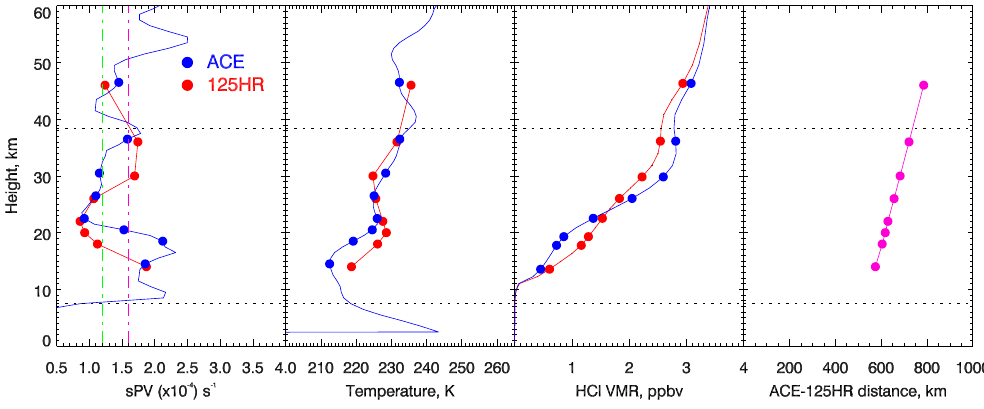
Fig. 8. As for Fig. 6, but demonstrating a less-well-matched comparison pair recorded on the 6 March 2007. Note the differences in sPV at 30 and 18km, with the two instruments each sampling a combination of air masses located inside and outside the polar vortex. The difference between the two measurements over the 11.02–38.40km partial column is